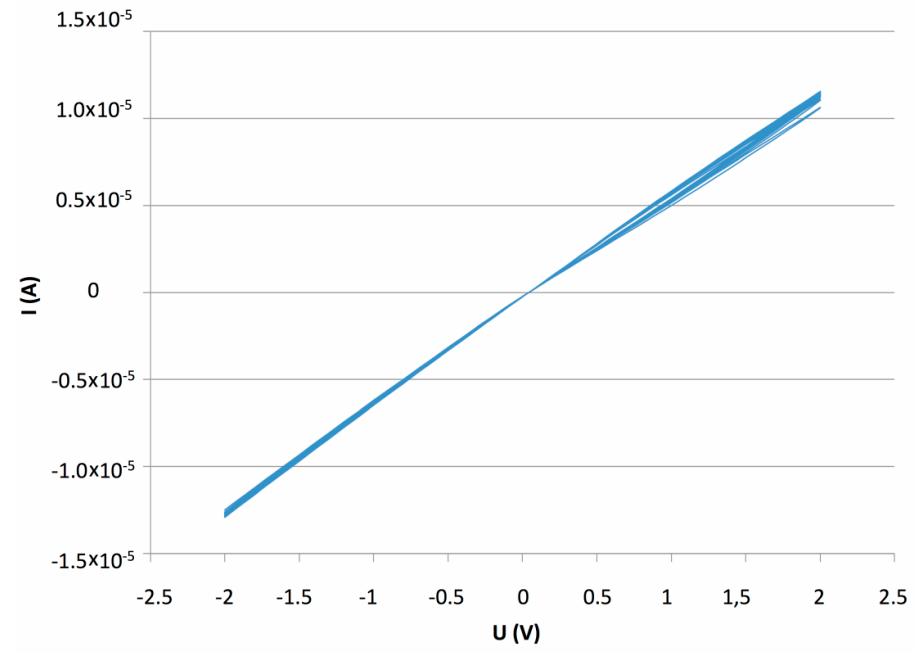
device (E5), between −2 and +2 V. 20